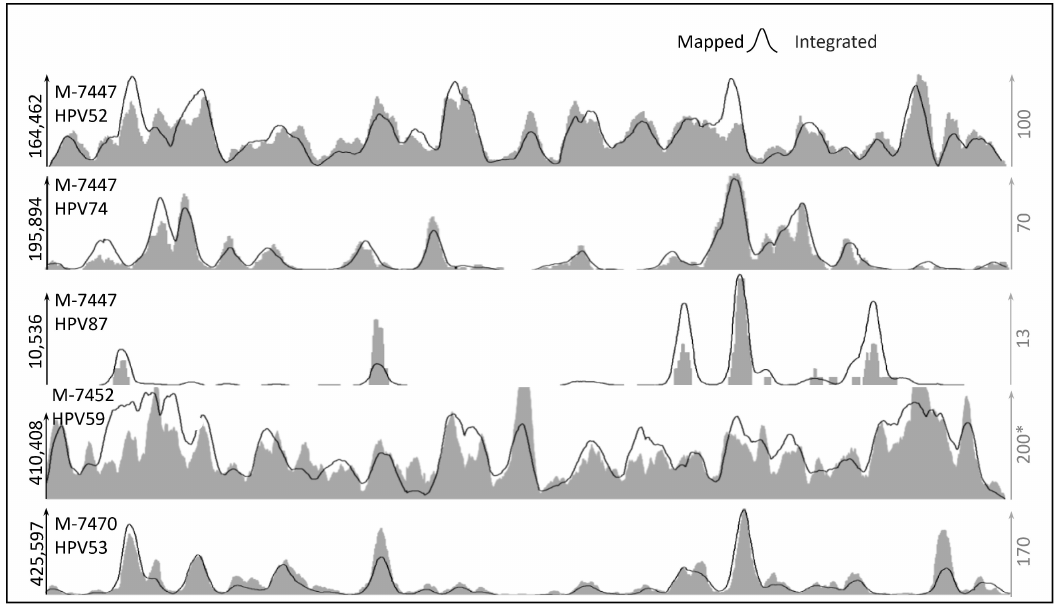
Figure 4. Comparison of mapped and putatively integrated reads. The vertical axis shows the number of reads. The horizontal axis represents the HPV genome coordinates from 0 to 8000 bp approximately. * Scale for M-7452 in integrated reads is reduced to half to clarify correlation (3 peaks are